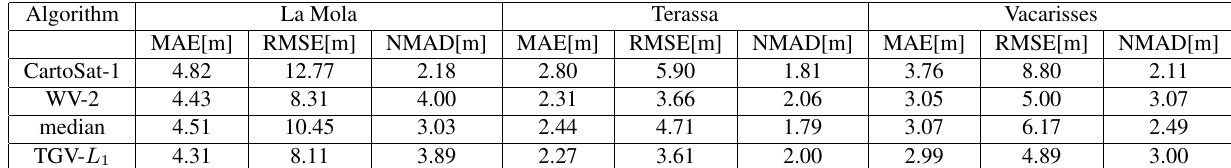
Table 2: Results of local median fusion and global TGV- L 1 fusion for heterogenous sensor data (CartoSat-1 and WorldView-2 satellite images). The first two rows show the accuracy of the unfused DSM of each satellite separately, whereas the two bottom rows show the fusion results of the two DSMs per